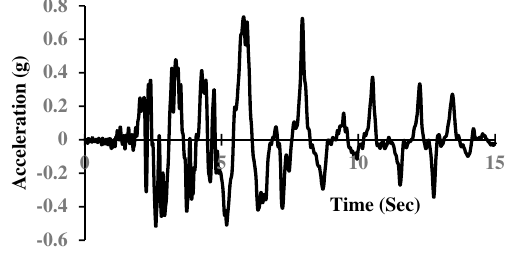
Fig. 5 Acceleration time-history of 1995 Kobe earthquake motion